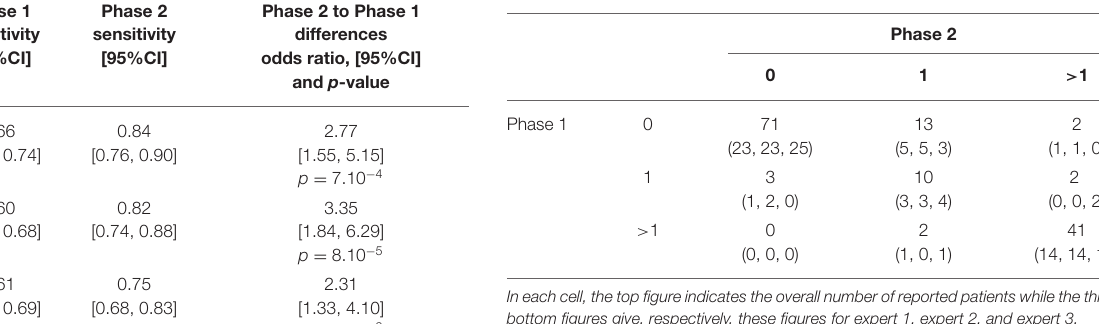
Pooled standard deviation from interexpert variability First row: averaged patient-wise number of lesions detected in phase 1 (column 1) and 2 (column 2) and mean difference, associated 95% CI and p-value for a null difference between the two phases (column 3). Second row: pooled inter-expert standard deviation associated with lesions number detected in phase 1 (column 1) and 2 (column 2) and mean difference, associated 95% CI and p-value for a null difference between the two phases (column 3).